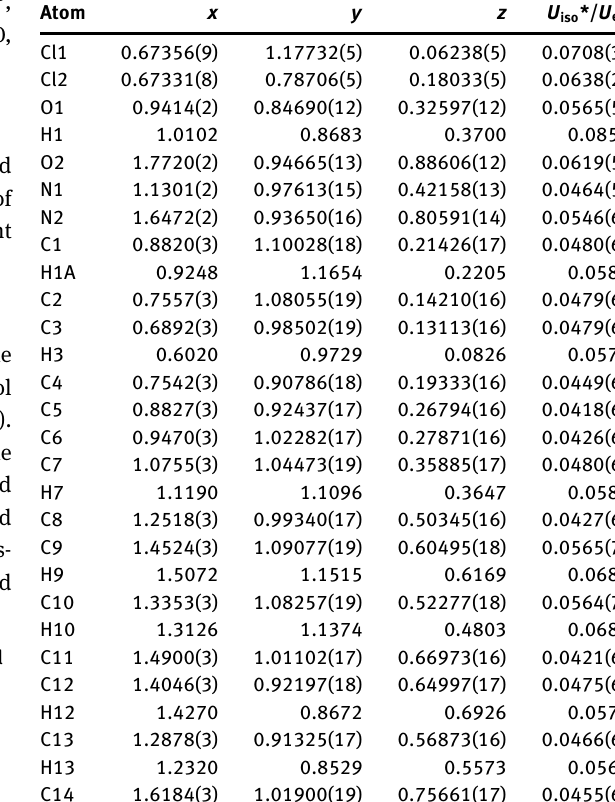
Table 2: Fractional atomic coordinates and isotropic or equivalent isotropic displacement parameters (Å 2